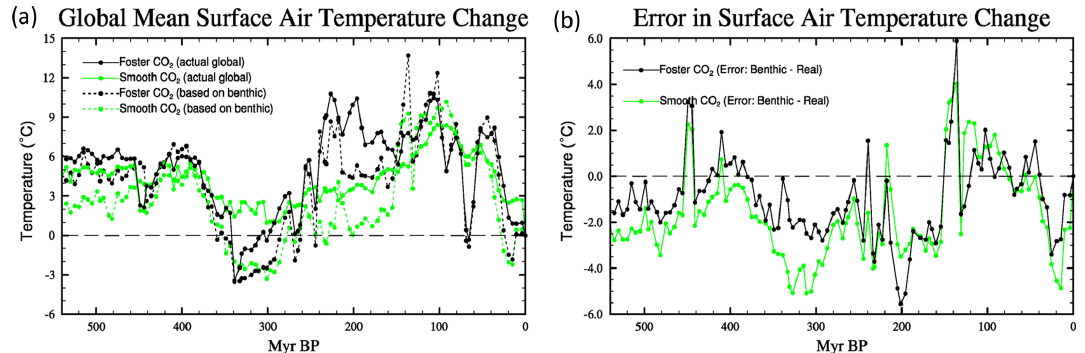
Figure 12. Phanerozoic time series of modelled temperature change (relative to pre-industrial) for the smooth (green lines) and Foster CO 2 (black) simulations (a) showing the actual modelled global mean surface air temperature (solid lines), whereas the dashed line shows the estimate based on deep ocean temperatures, and (b) error in the estimate of global mean temperature change if based on deep ocean temperatures (i.e. deep ocean – global mean surface